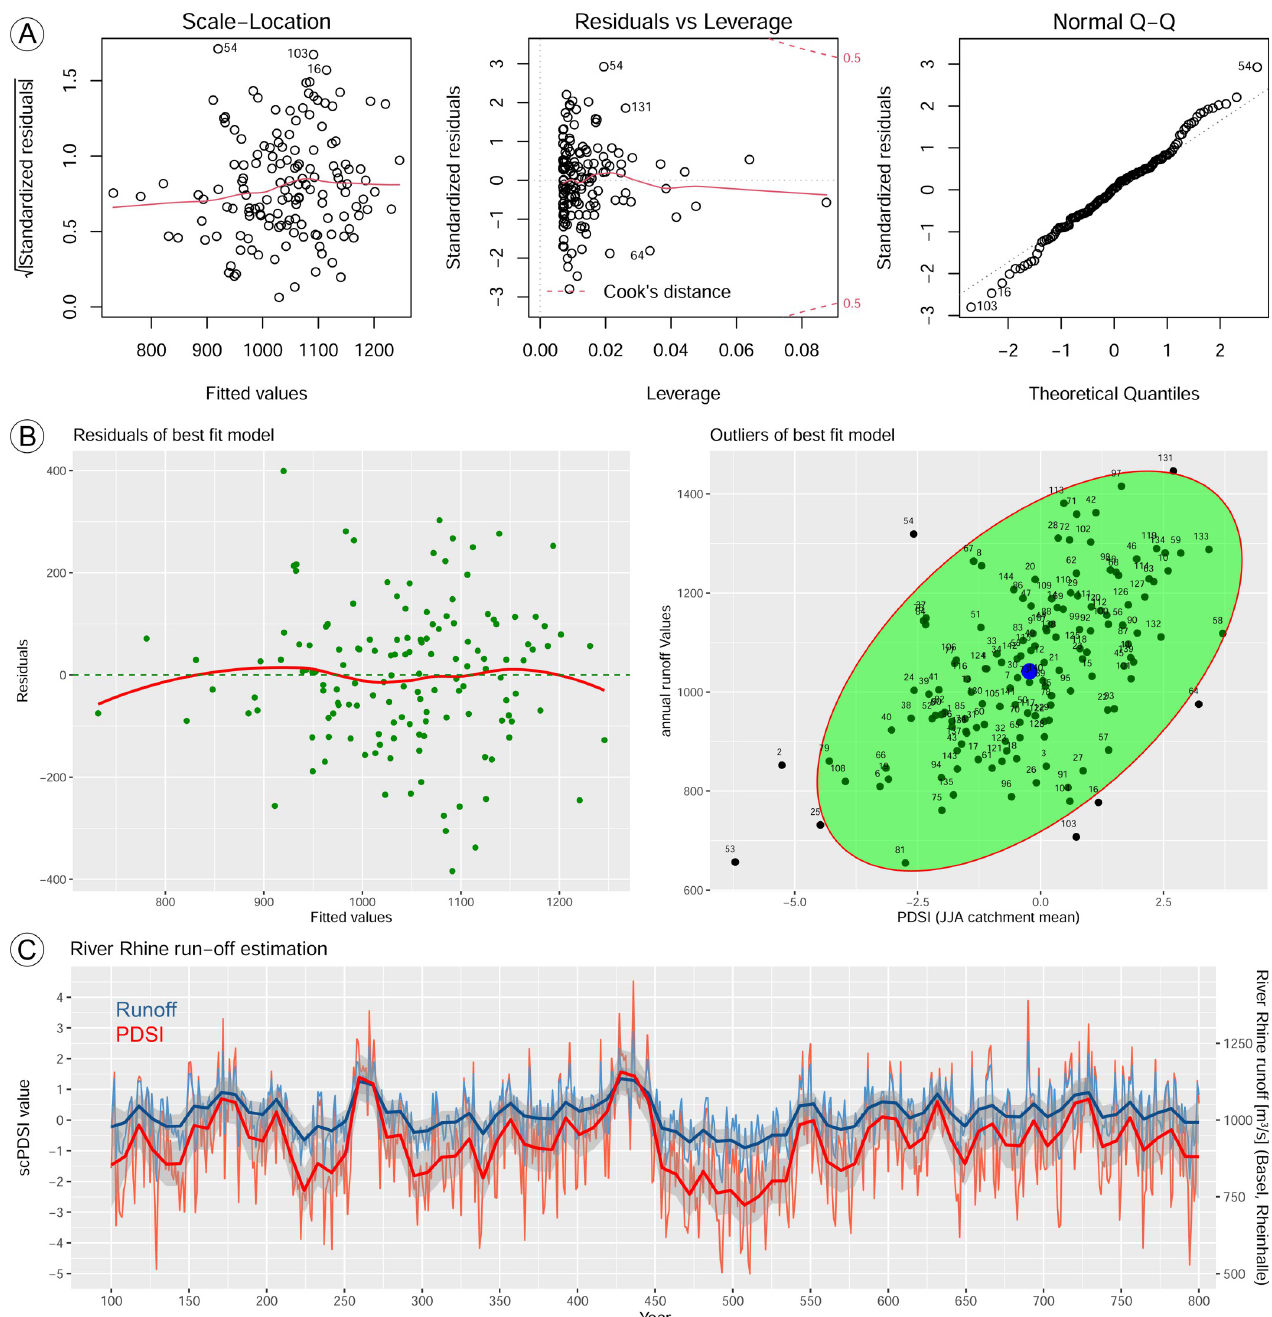
Fig 8. Model performance of PDSI predicting annual run-off at Basel and run-off estimation for the period 100–800 AD. (A) Model output, (B) residuals plot and Mahalanobis outliers; (C) estimated run-off behavior based on the predictor variables from the linear model.